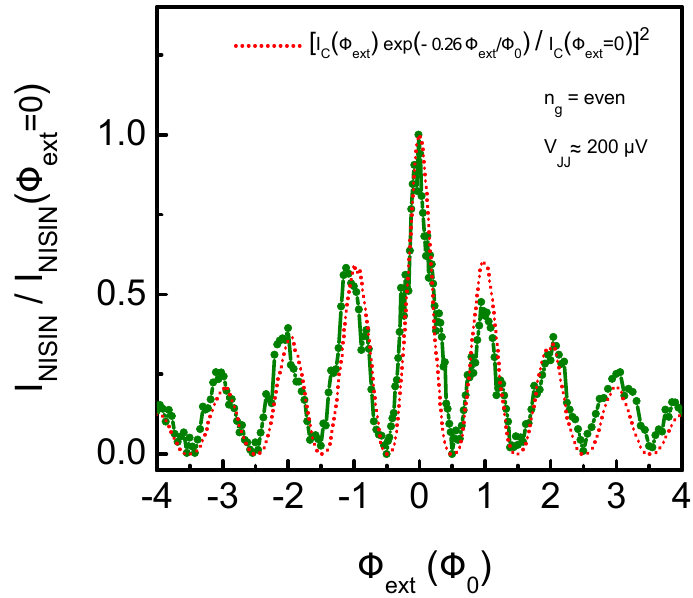
Figure 8. Normalized detector response as a function of the magnetic flux (green curve). The red dotted curve is a phenomenological fit including an exponential decay expression shown in the